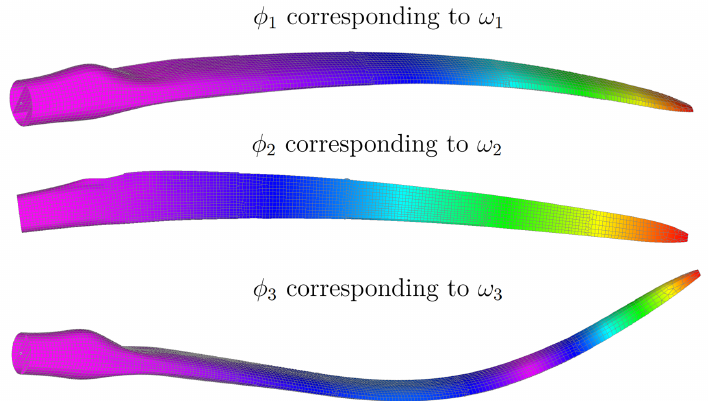
Figure 24. FEA vibration modes eigenvectors of the extracted solution of MOSOP4.